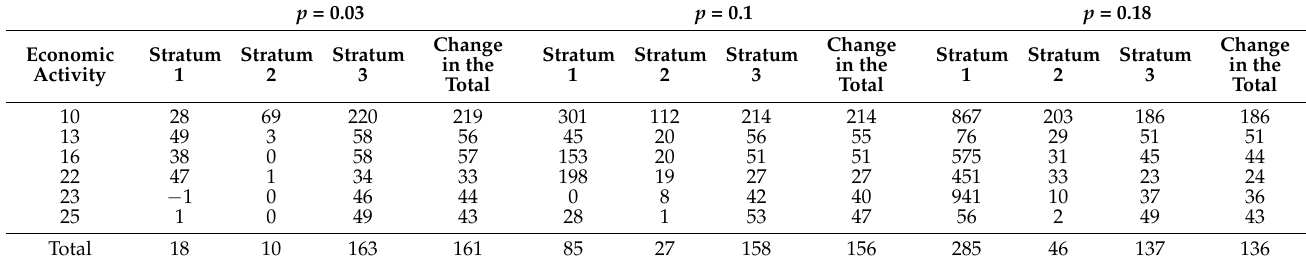
(cid:17) (cid:16) ˆˆ t yh for the estimators of totals in the strata.